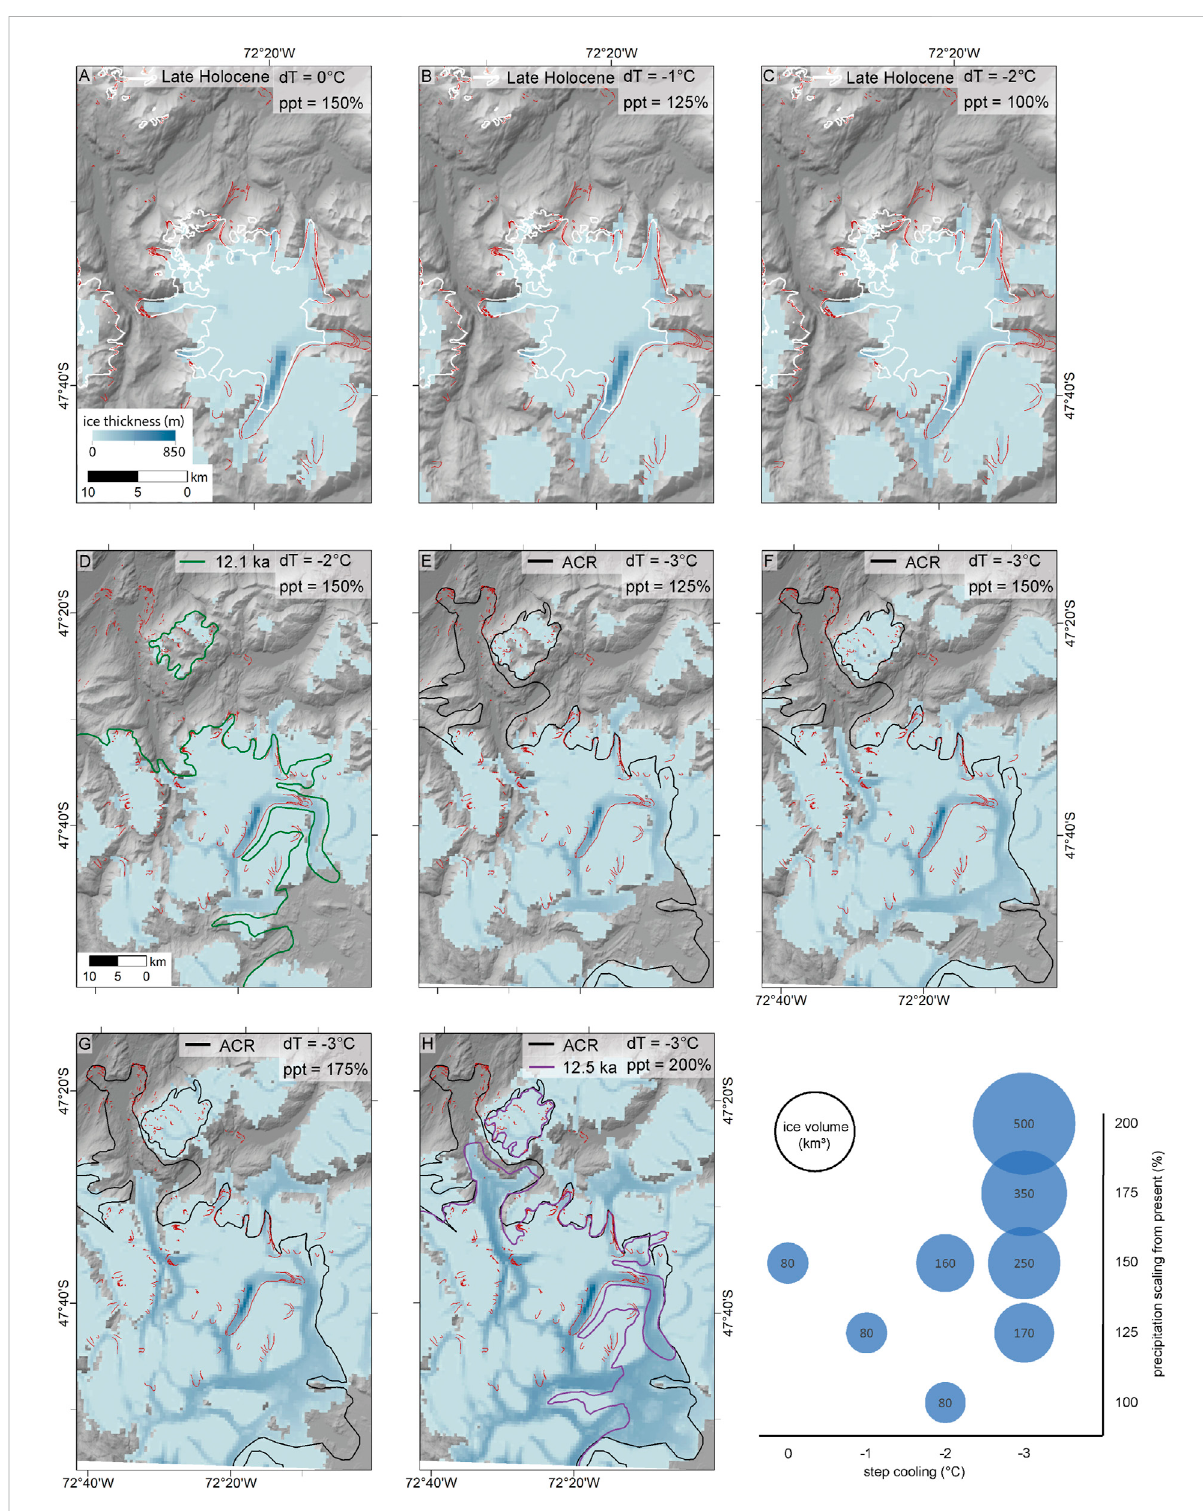
FIGURE 9 ModelsimulationsoftheMSLicecapundercombinedsurfaceairtemperaturestepcoolingof1 – 3 ° Candprecipitationscalingof125% – 200%to best fi t palaeo ice mass reconstructions from the Late Holocene (A,B) , mid-Holocene (B,C) , ca 12.1 ka (D) , 12.5 ka and the ACR (E-H) . Moraines are shown in pink. Scatter plot shows how ice volume changes with different combinations of temperature and precipitation